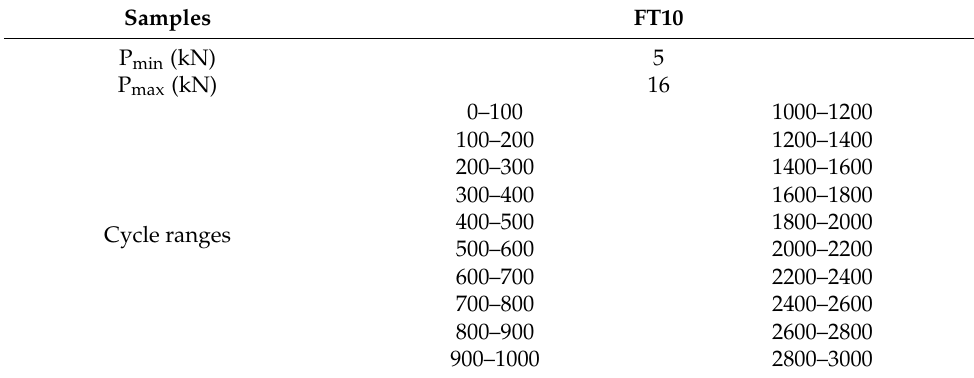
Table 2. Cycle loading